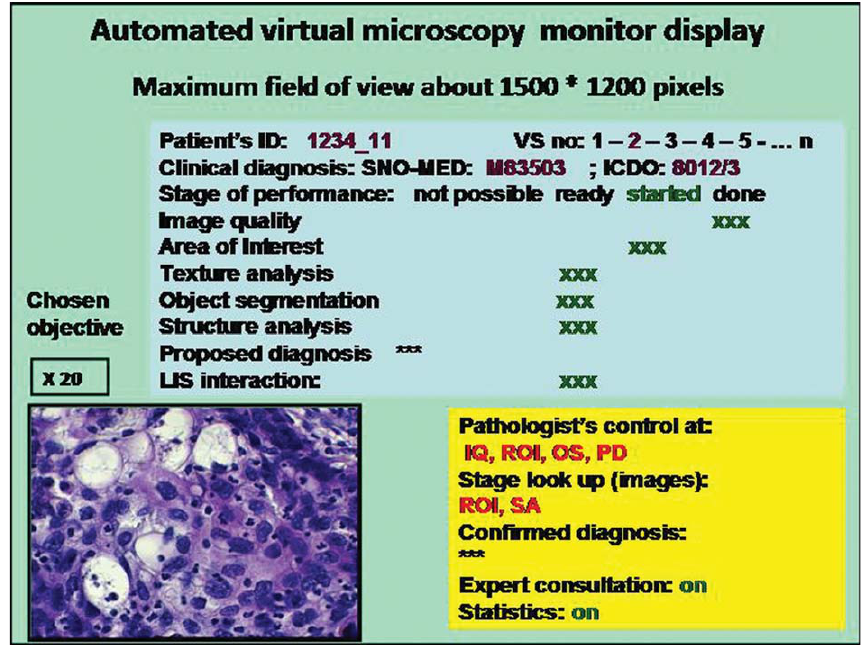
Fig. 6. Proposed scheme of monitoring an automated VM by the